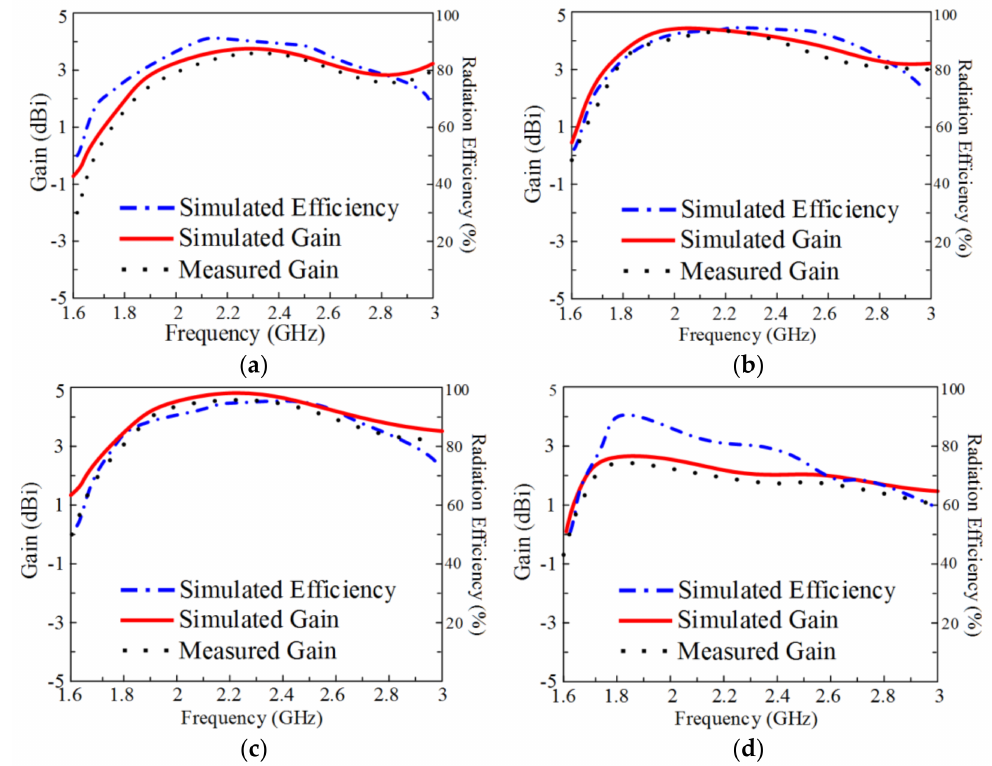
Figure 13. Radiation gain and efficiency curves over the frequency band of proposed antenna for ( a ) case-00, ( b ) case-01, ( c ) case-10, and ( d )